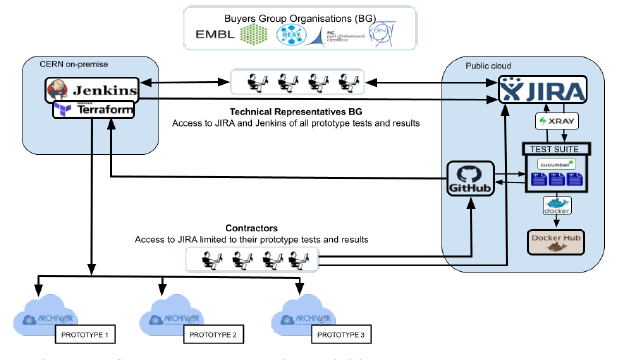
Fig. 9. Continuous Testing Environment for ARCHIVER’s testing